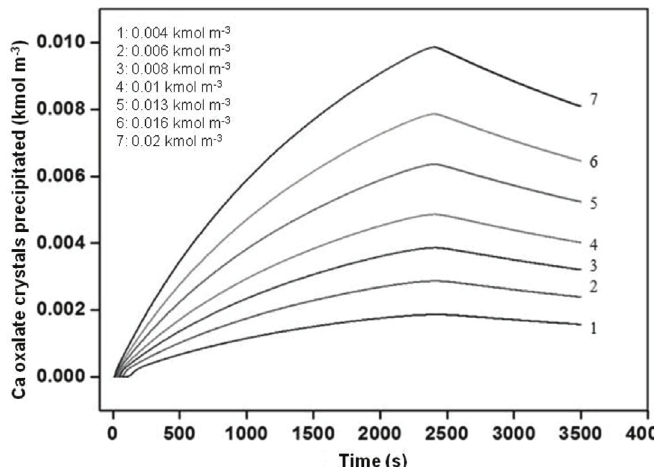
Fig. 6 – Model prediction of product crystals precipitated with different initial concentrations of reactants during process at 5 mL min –1 feed